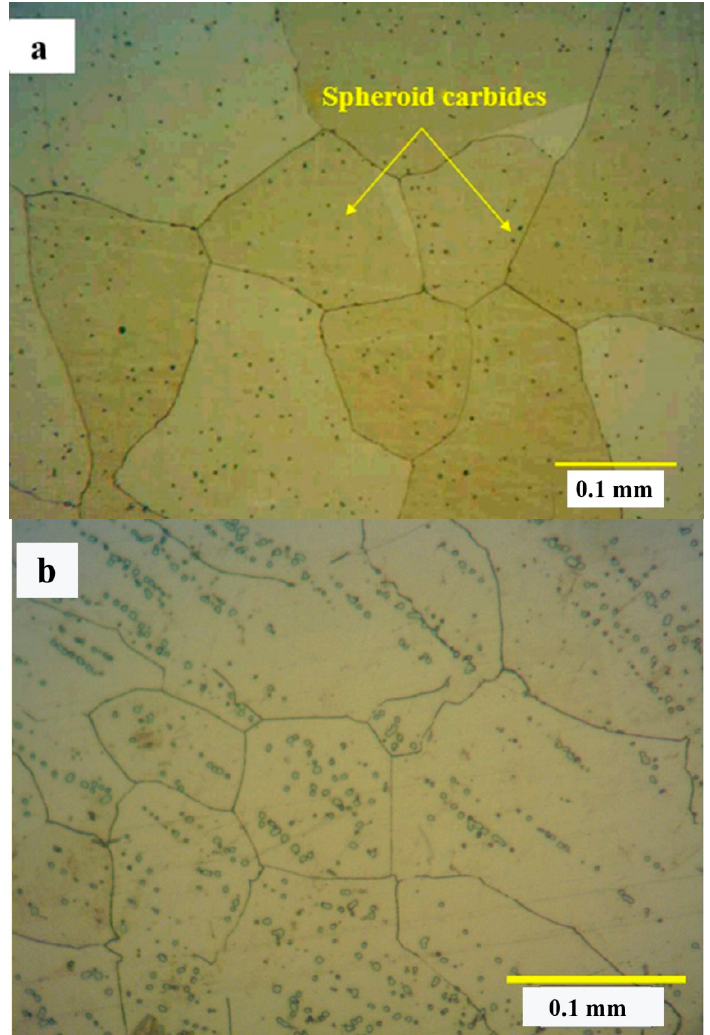
Figure 3. Microstructure of ( a ) the sample solution treated at 1230 ° C for 3 h and ( b ) the sample solution treated at 1200 ° C for 1 h.